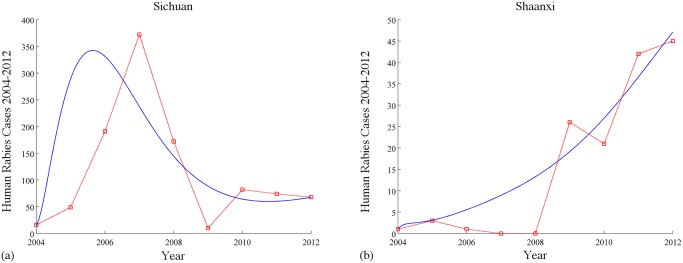
Simulations of the numbers of reported human rabies cases in Sichuan and Shaanxi from 2004 to 2012.The solid blue curves are simulation results by our model and the dashed red curves are the numbers of reported cases by China CDC [25]. Values of parameters: A
1 = 3 × 105, A
2 = 3 × 105, B
1 = 7.184 × 105, B
2 = 3.634 × 105, λ1D=λ2D=0.33, λ1H=λ2H=2,σ1D=σ2D=10, σ1H=σ2H=6, γ1D=γ2D=0.4,γ1H=γ2H=0.475, m1D=m2D=0.345, m1H=m2H=0.00662, k1D=0.09, k2D=0.09, k1H=k2H=0.5, μ1D=μ2D=μ1H=μ2H=1, β1D=2.7×10−6, β2D=2.4×10−6, β1H=9.5×10−10, β2H=4×10−11, ϕ12S=ϕ12E=ϕ12I=ϕ12V=0.03, ϕ21S=ϕ21E=ϕ21I=ϕ21V=0.4, ψ12S=ψ12E=ψ12V=0.3, ψ21S=ψ21E=ψ21V=0.05, ψ12I=ψ21I=0.